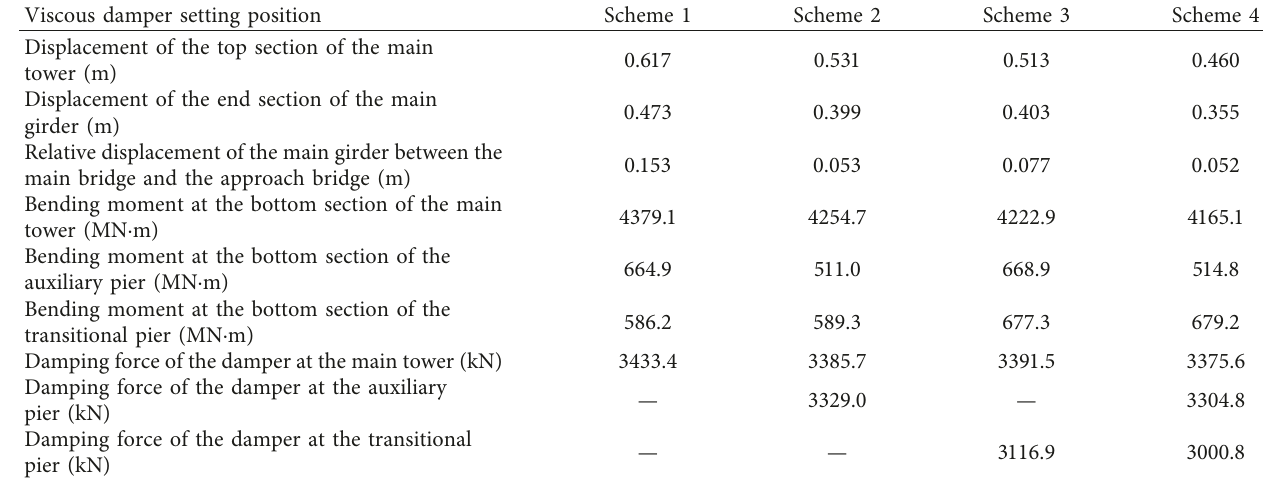
Table 6: Longitudinal structural response of the four schemes viscous damper setting